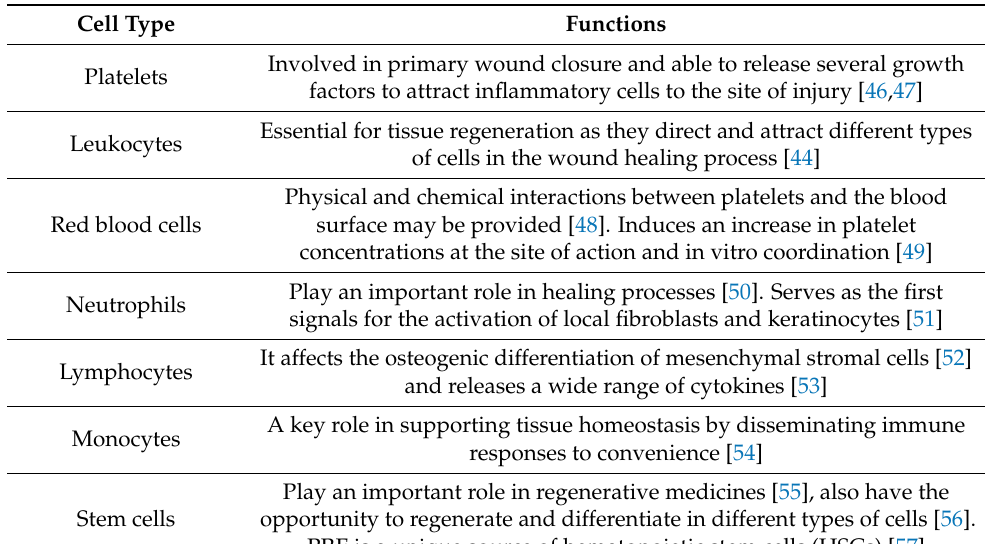
Table 3. Description of cells within the